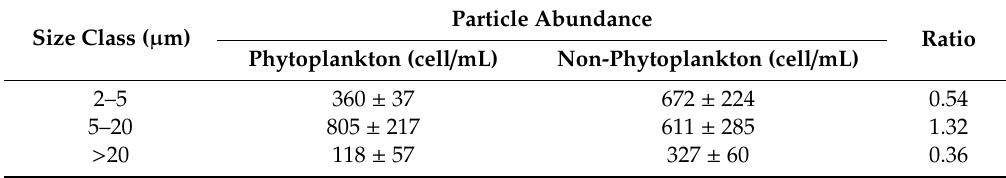
Table 6. Phytoplankton size classes and abundance (mean ± s.d.) during biodeposition measurements in August.